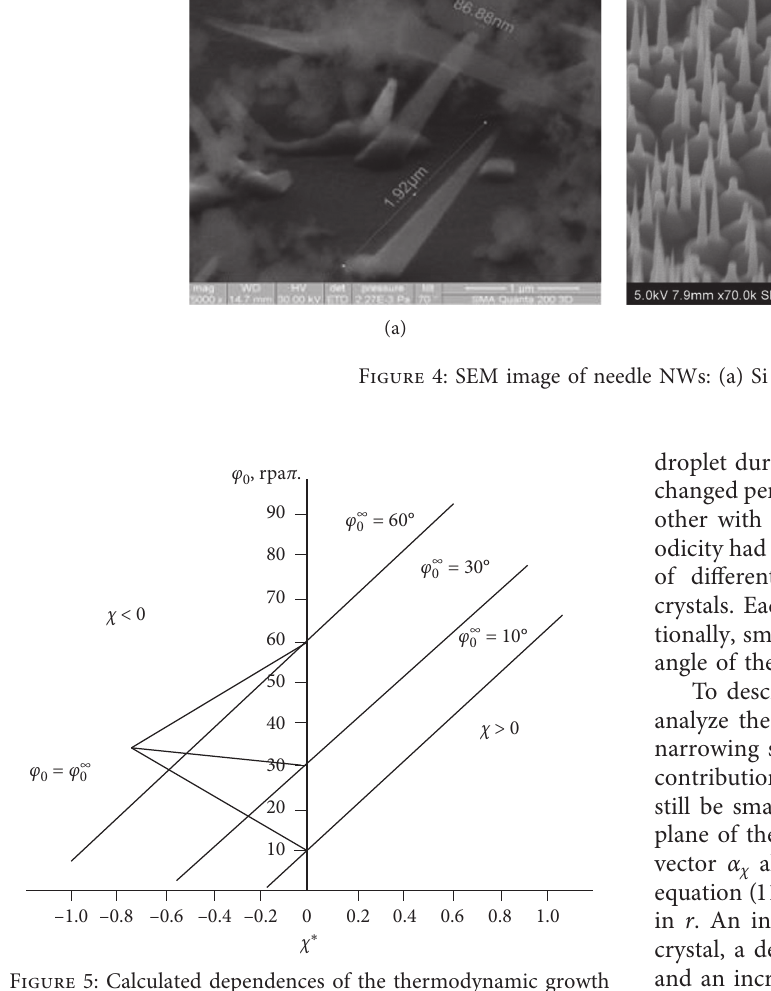
Figure 5: Calculated dependences of the thermodynamic growth angle of Si NWs on the dimensionless curvature of the TPL χ ∗ � χ / α L r for different values of the whisker growth angle φ ∞ characterizes the macroscopic droplet ( r ⟶ ∞